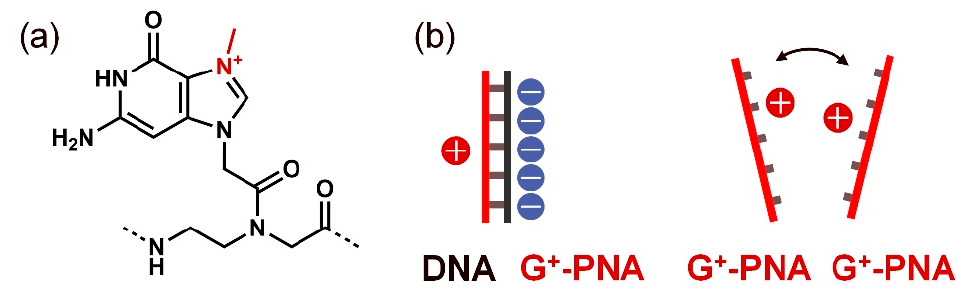
Figure 9. ( a ) Structure of cationic guanine PNA (G + -PNA). ( b ) Enhancement of DNA affinity and suppression of self-duplex formation through electrostatic interaction by using G + -PNAs.